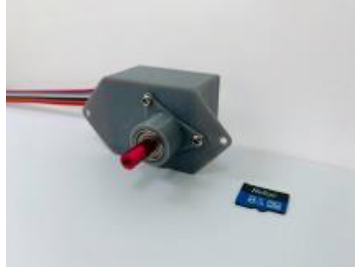
Figure 2. Angle sensor.